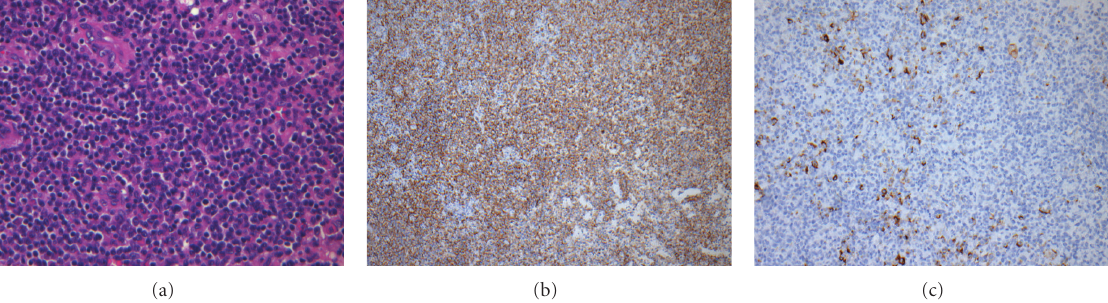
Figure 1: Histological and immunohistochemical analysis of posttransplant EBV-associated di ff use large B-cell lymphoma in the CNS. (a) H&E section showing di ff use infiltration by large neoplastic lymphocytes ( × 20). (b) Immunohistochemistry showing neoplastic lymphocytes are strongly positive for CD20 ( × 20). (c) Immunohistochemistry showing scattered tumor cells positive for EBV ( × 20). system posttransplant EBV - associated lymphoproliferative